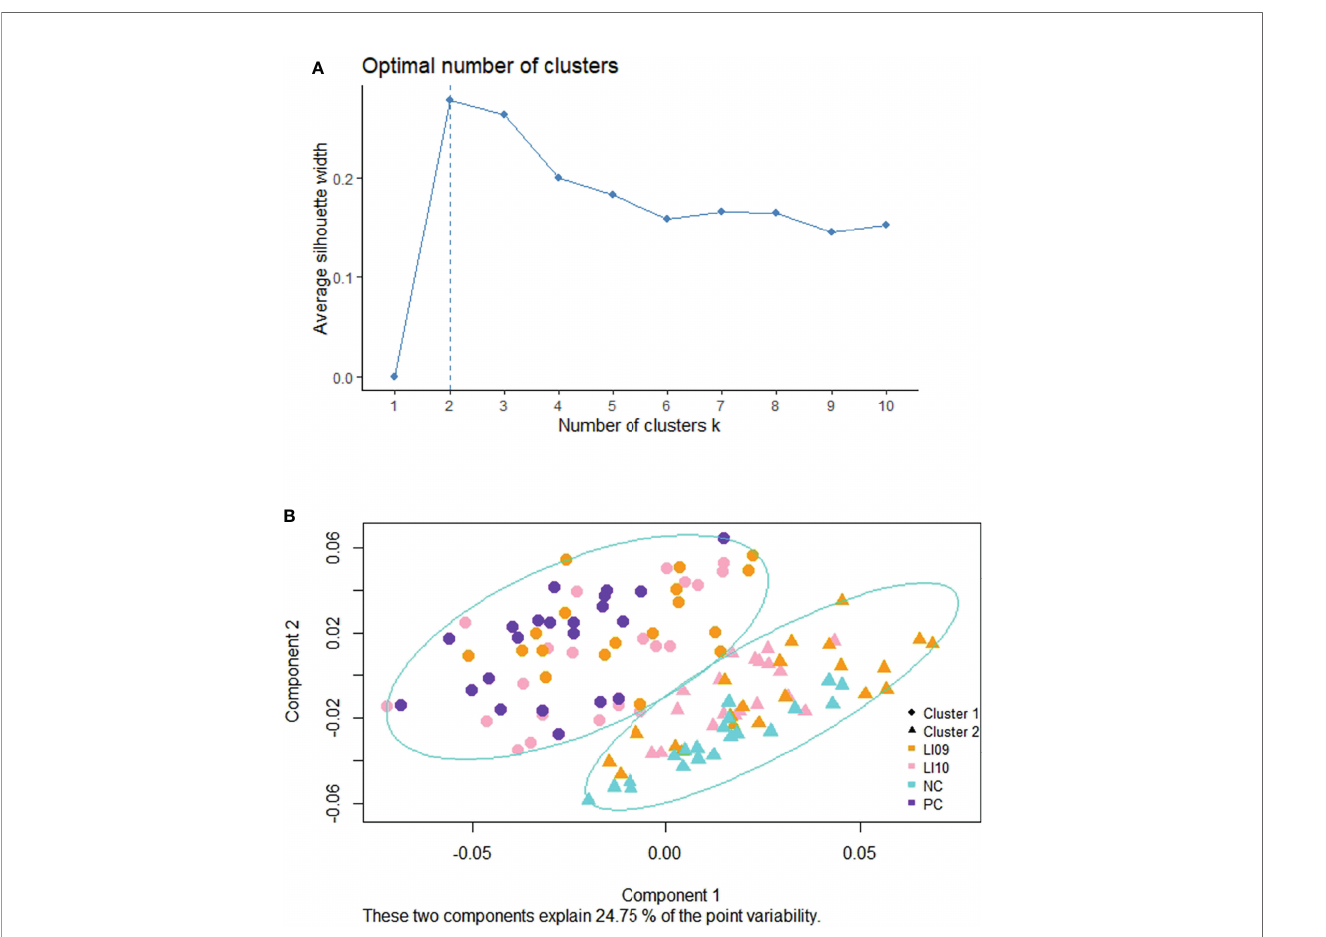
FIGURE 1 | Clustering of cytokine pro fi les in LI09 and LI10 cohorts. (A) Silhouette analysis determined the scores for the optimal clusters. (B) Partition around medoids clustering analysis determined the two cytokine pro fi les (i.e., CP1 and CP2) in all the recruited